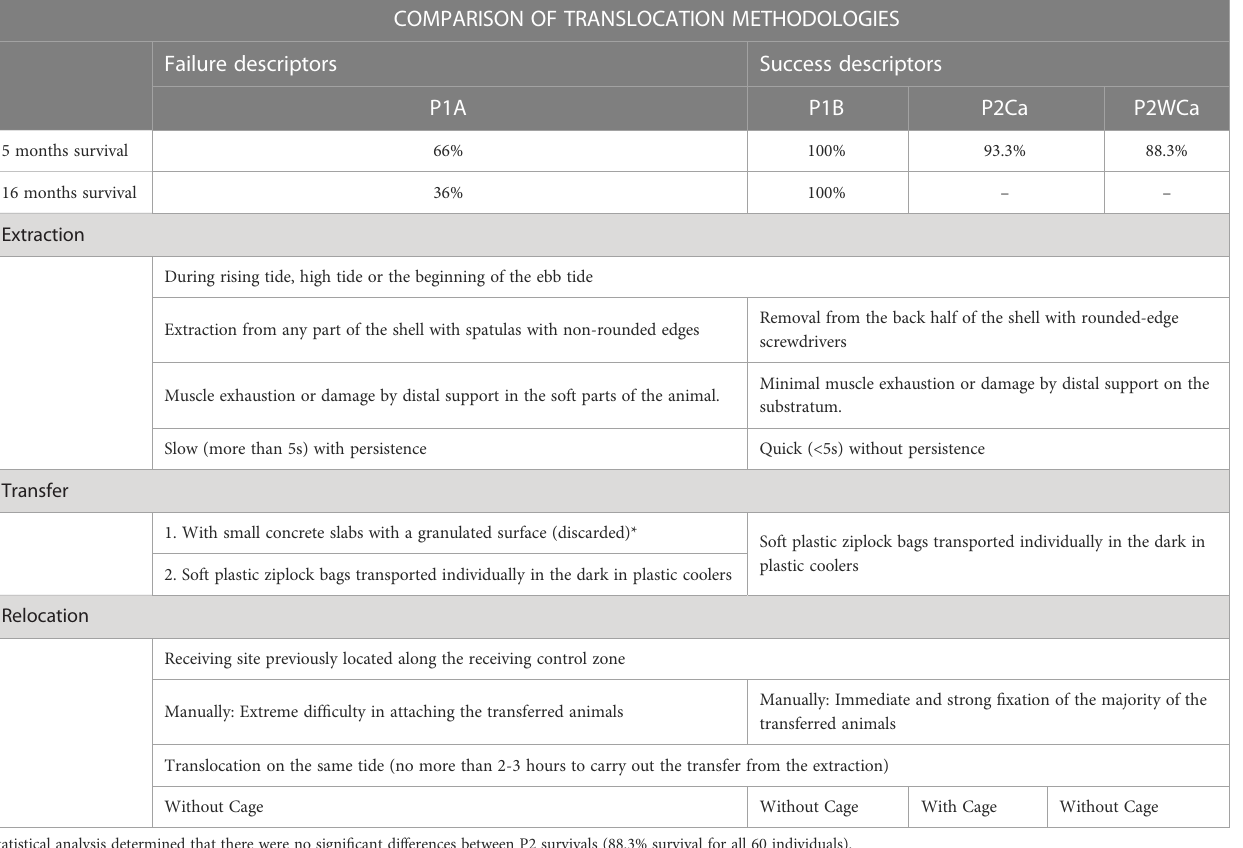
TABLE 3 Methodological results of failure (P1A) and success (P1B and P2), to be considered in further replication on translocation experiments of P.